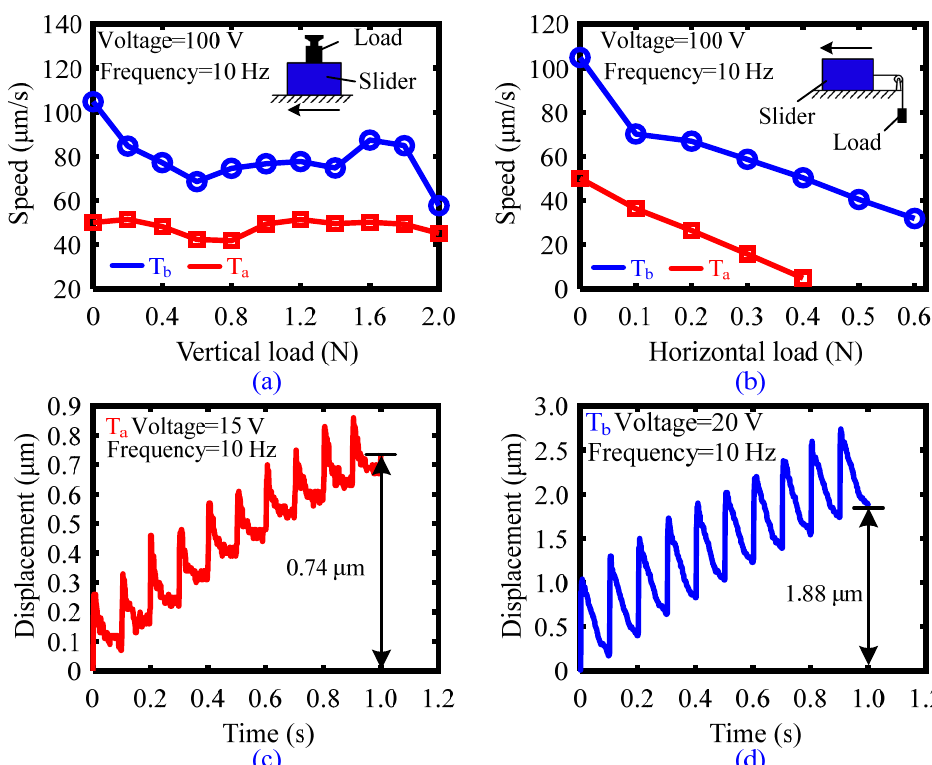
Figure 11. Motion speed change with ( a ) a vertical load and ( b ) a horizontal load. ( c , d ) Resolution testing results of the actuator with the T a and T b microstructures without an external load.